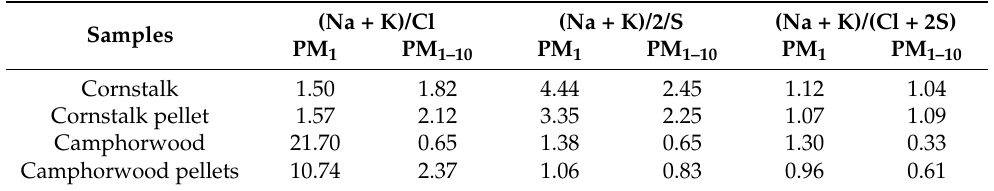
Table 6. Molar ratio between main elements in